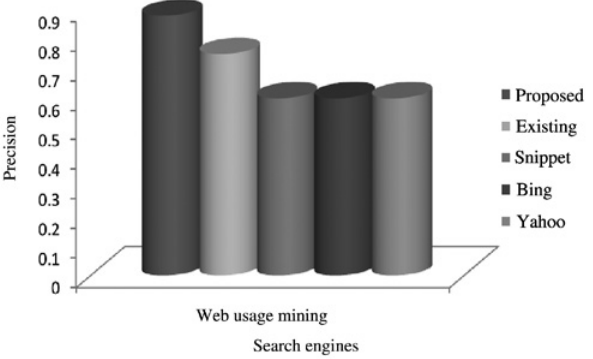
Figure 4: Precision Comparison for the User-Given Query “Web Usage Mining” When Topmost Links Are